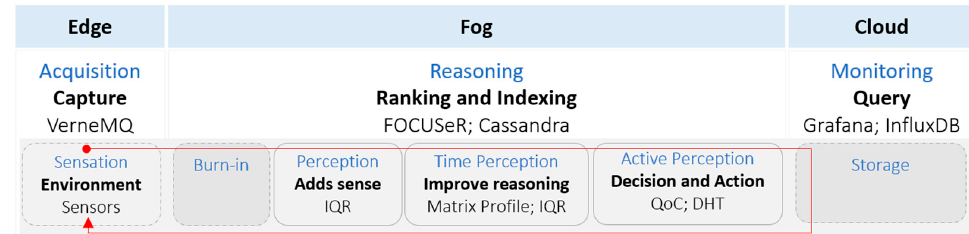
Figure 6. Overview of FOCUSeR method.